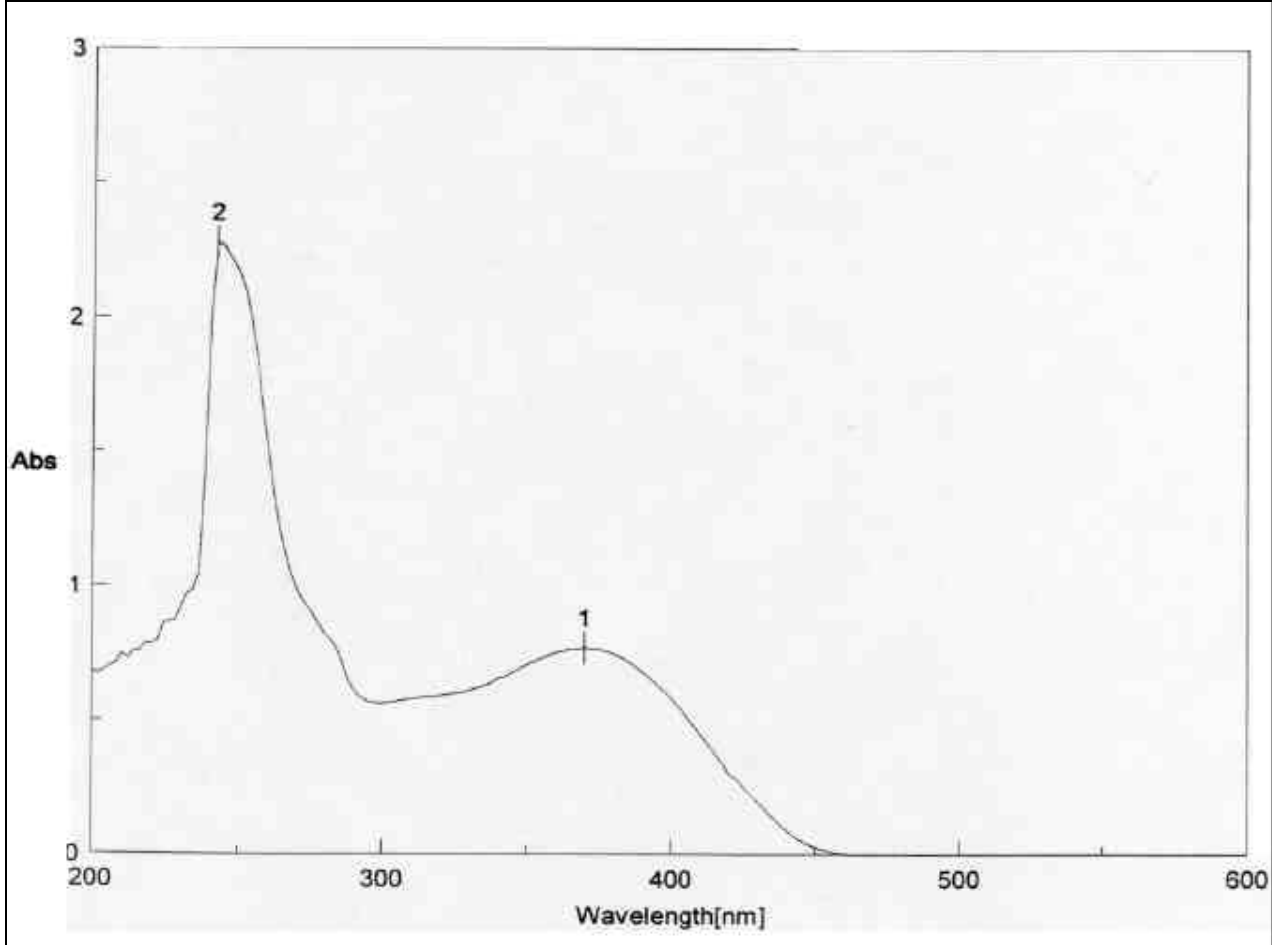
Figure 3. UV absorbance spectrum of 1 in chloroform. 8